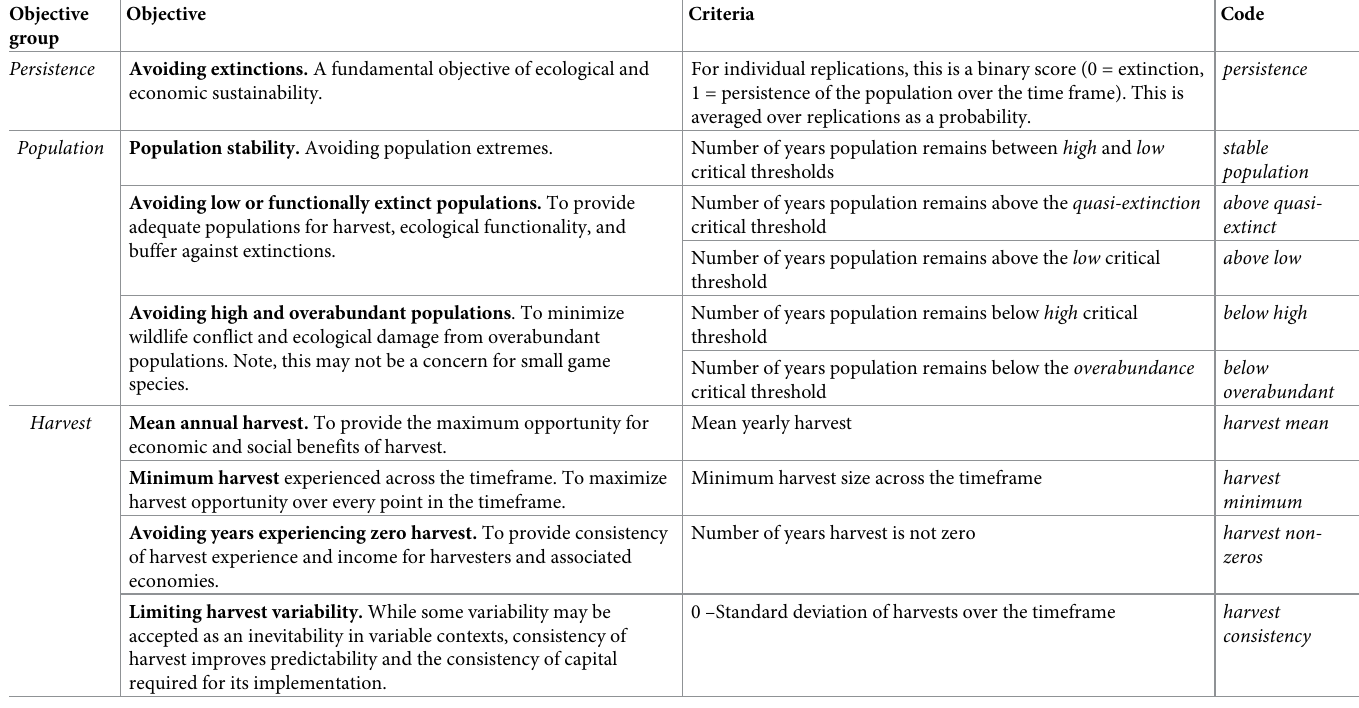
Table 1. Individual sustainability